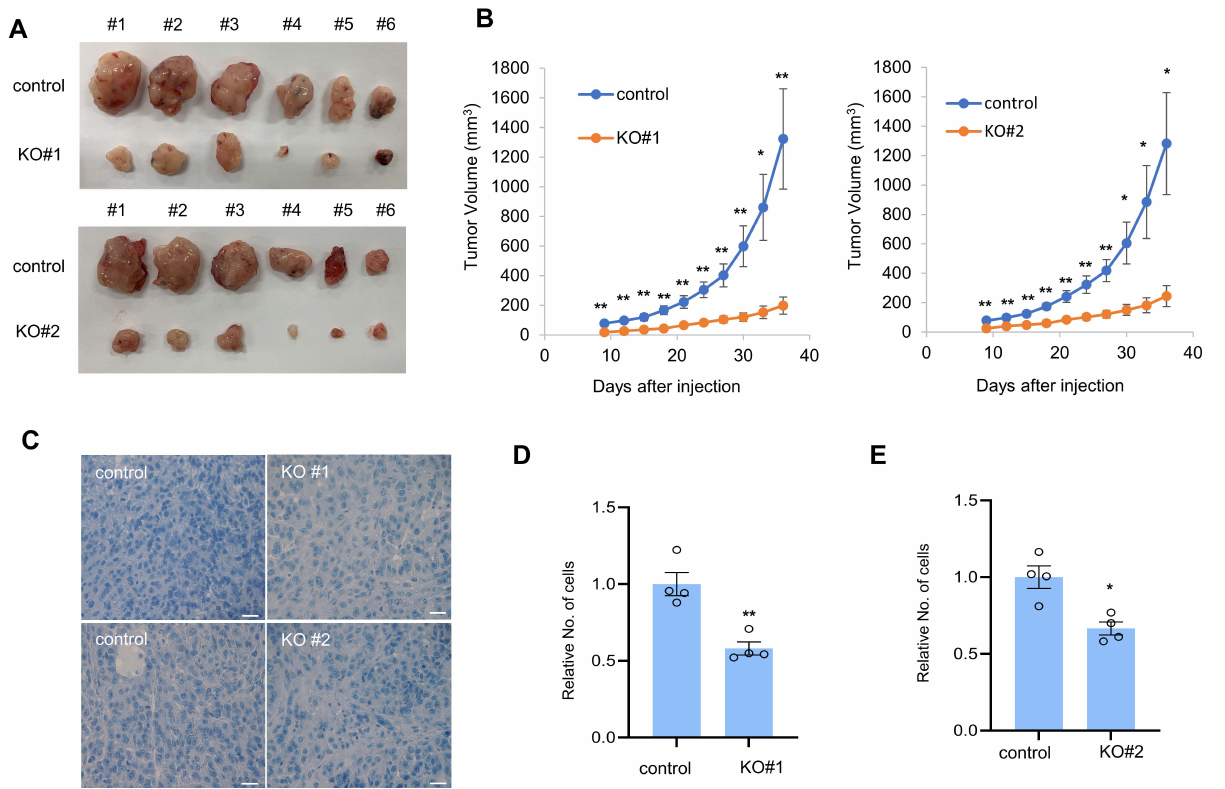
Figure 4. CTRP1 knockout cells show decreased tumor formation in a xenograft mouse model. ( A ) CTRP1 knockout A549 cells did not induce tumors in athymic nude mice. Control and